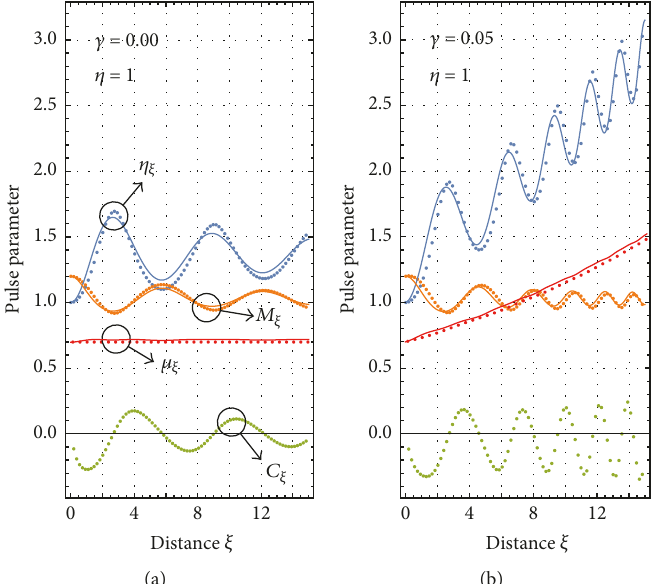
Figure 8: Parameter evolution and soliton content (red) of an initial unchirped 𝑁 = 1.2 sech pulse in the case without gain (a) and with gain (b). Again solid curves/dots correspond to the model/numerics, respectively.